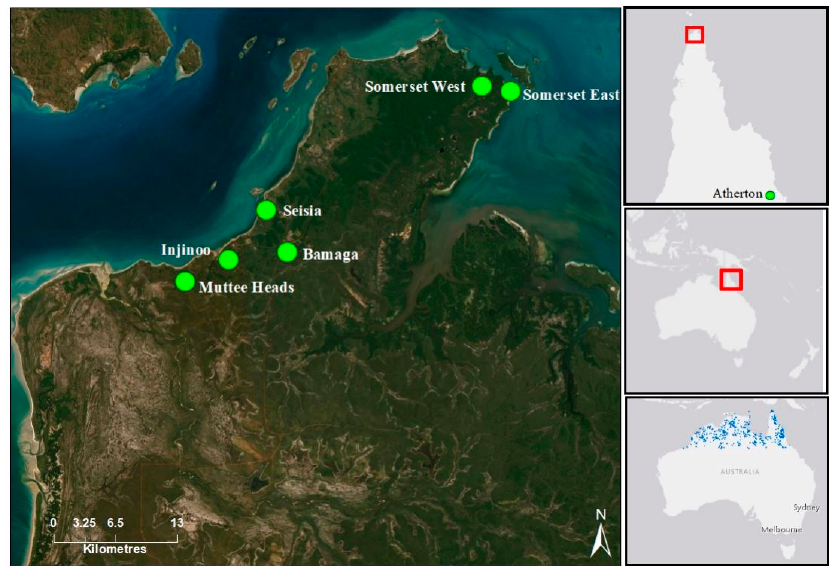
Figure 1. Main image showing the approximate extent of the Northern Peninsula Area (NPA) region of Cape York (Queensland, Australia), displaying six Santalum lanceolatum sampling locations (green points). Top right map is of Cape York Peninsula (approximate extent of NPA in red) and approximate area (green point) of the two southern populations. Centre right map shows extent of the Cape York Peninsula in red. Bottom right displays the approximate distribution of S.lanceolatum represented by blue points.